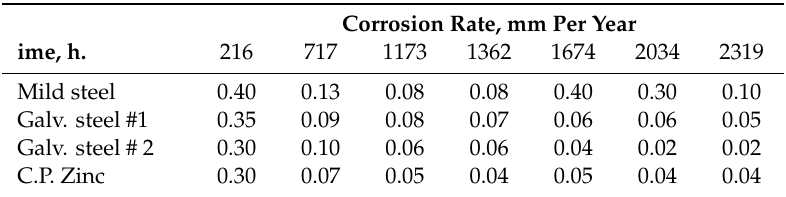
Table 8. Rate of corrosion of metallic sections in silos [11] “Reproduced with permission from